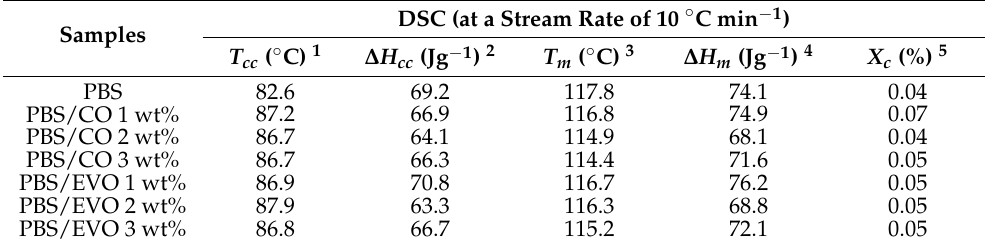
Table 2. Thermal properties of the studied formulations.